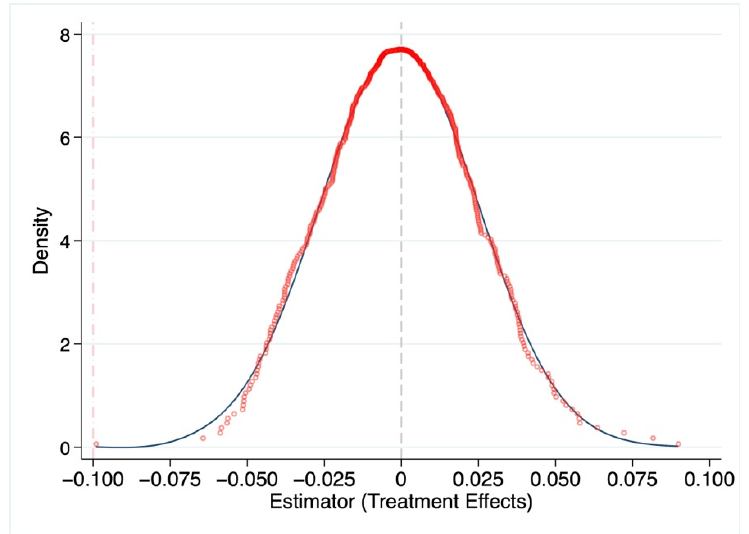
Figure 4. RDD placebo test. Table 3. Robustness of alternative dependent variables.